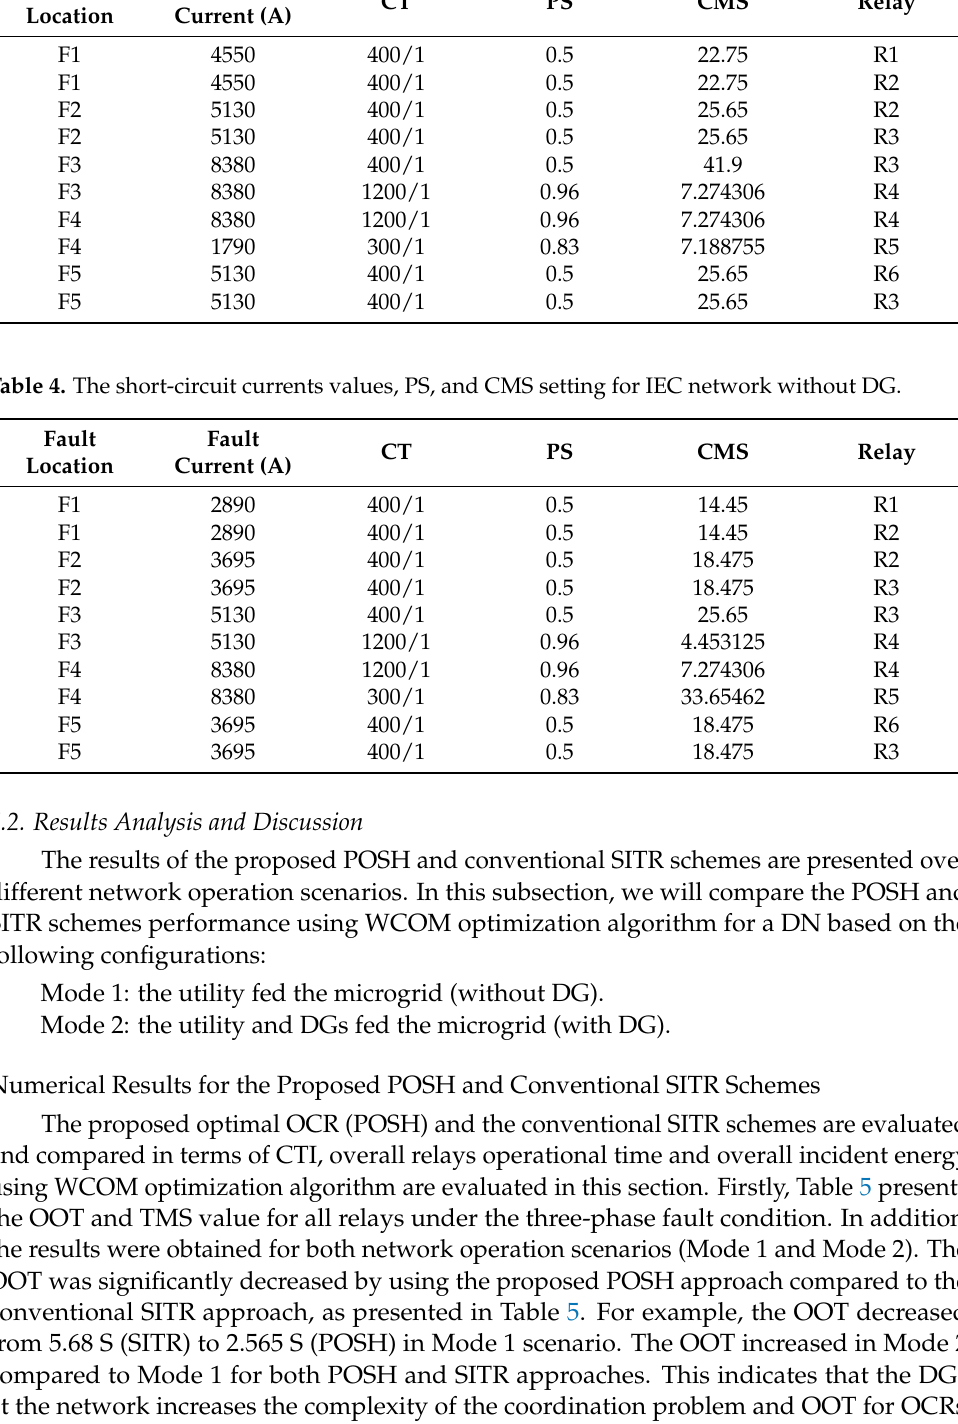
Table 3. The short-circuit currents values, PS, and CMS setting for IEC network with DG. Fault